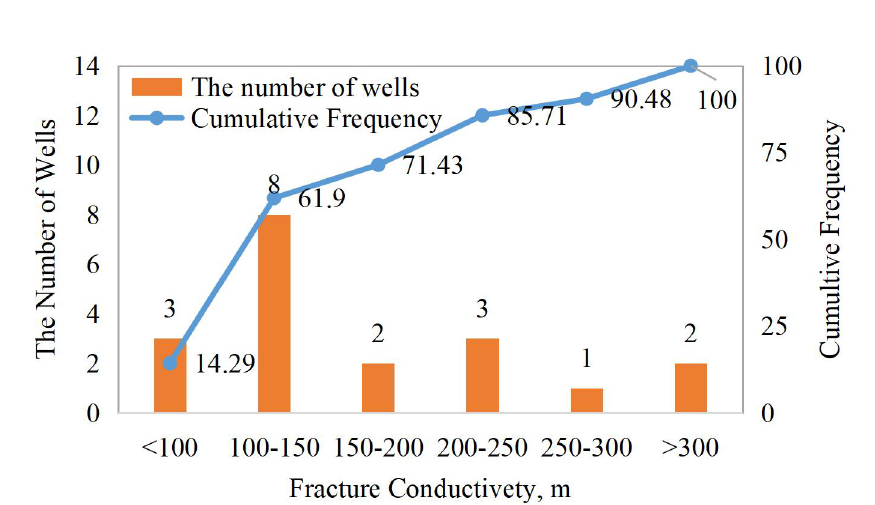
Figure 12—Cumulative frequency distribution of fracture half-length of vertical well.